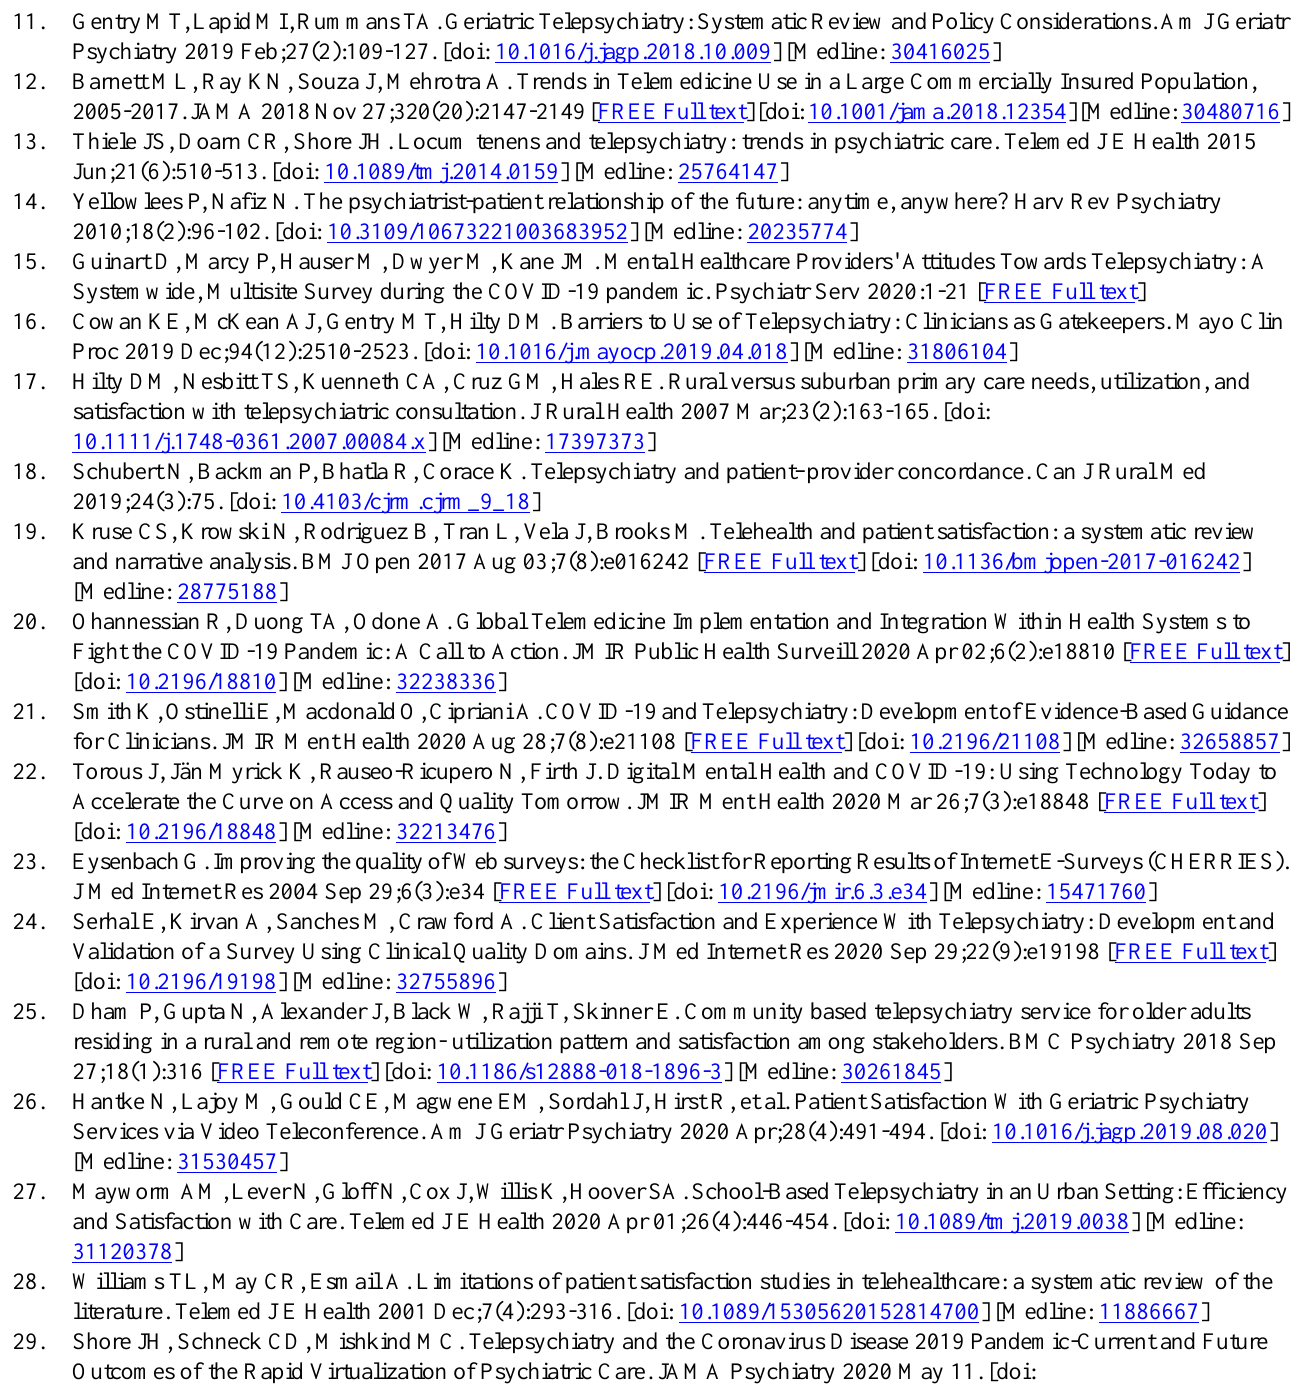
CHERRIES: Checklist for Reporting Results of Internet